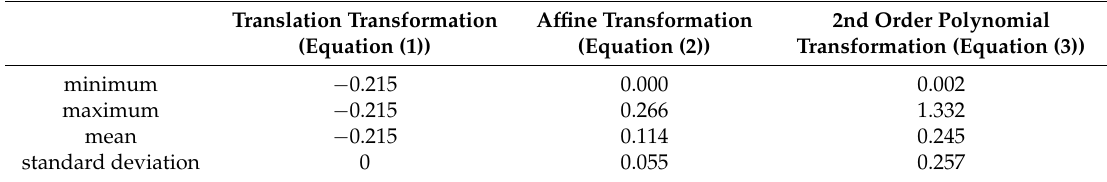
Table 4. Summary statistics (units 10 m pixels) of the Euclidean distances (Equation (6)) between the projected WELD tile pixel locations projected using the same transformation type but the coefficients in Tables 2 and 3. Derived considering all 15885 ˆ 15885 10 m WELD tile